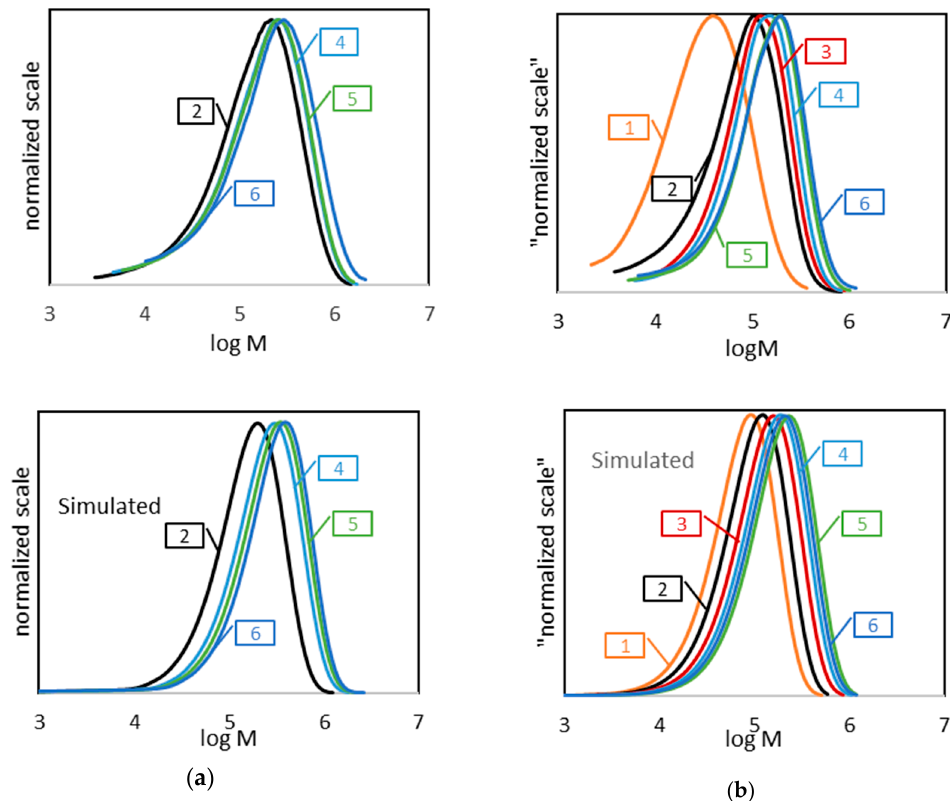
Figure 12. Evolution of the molar-mass distributions with DTL2 (experimental shown at the top and simulated at the bottom): ( a ) 300:2:1 and ( b ) 300:4:1. Labels: “1” = 40, “2” = 60, “3” = 90, “4” = 120, “5” = 150, “6” = 180 min.